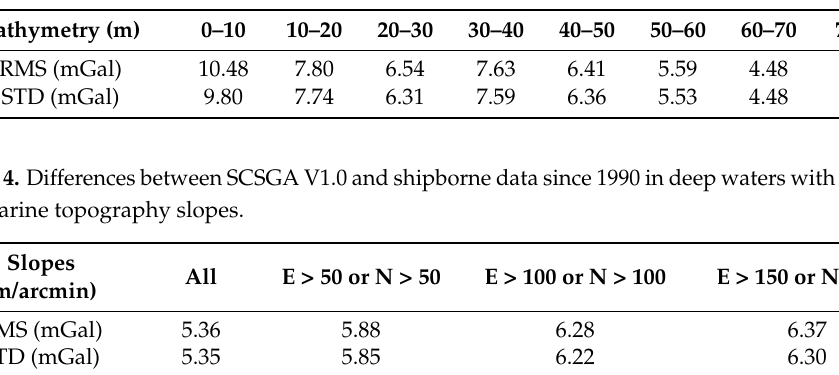
Table 4. Differences between SCSGA V1.0 and shipborne data since 1990 in deep waters with different submarine topog- raphy slopes.